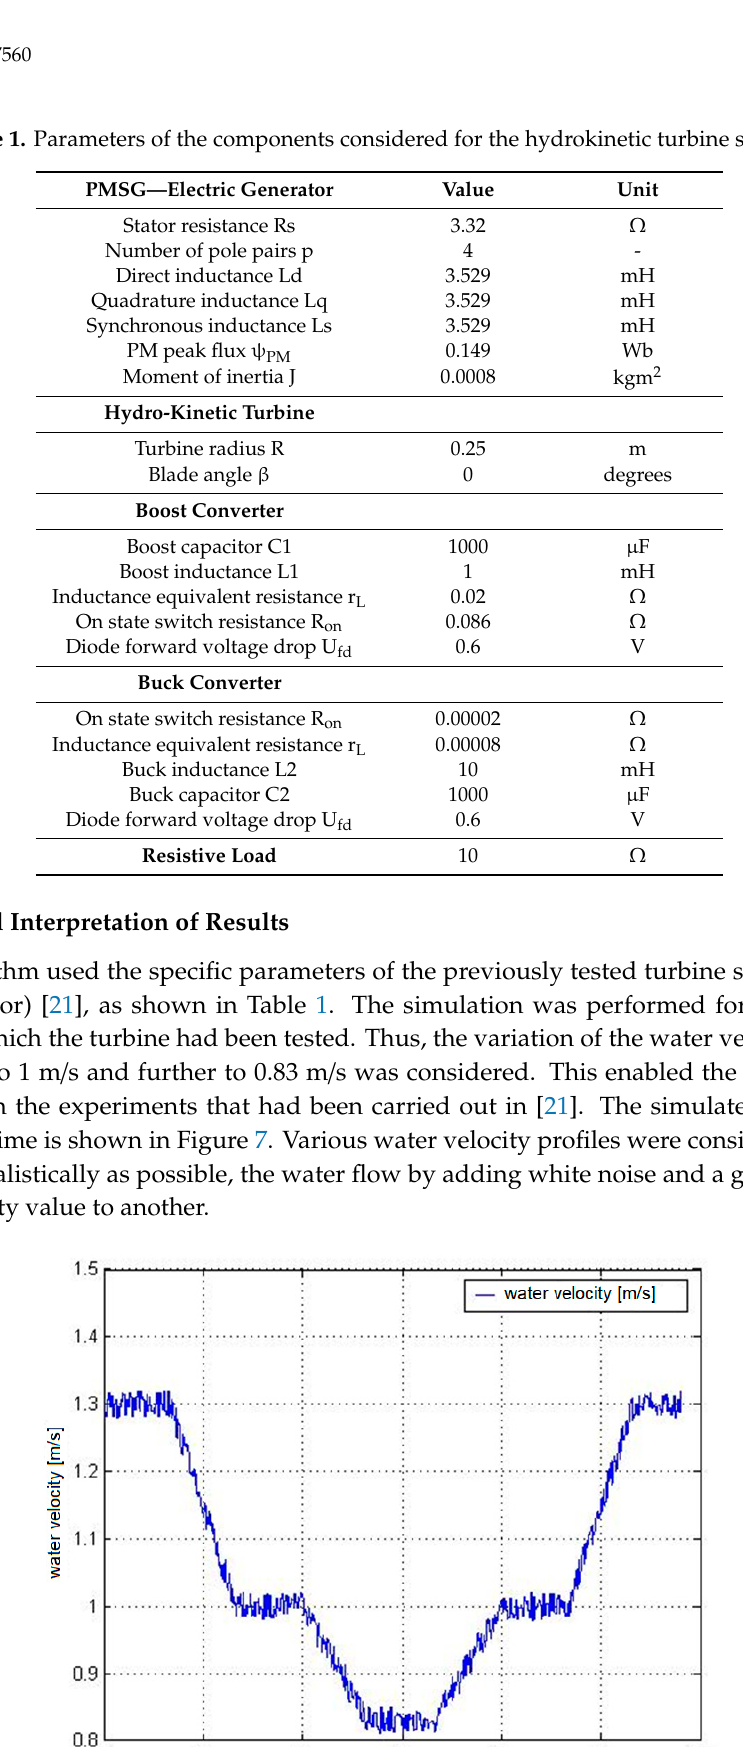
Table 2. Comparison between experimental and simulation results. Water Velocity (m/s)